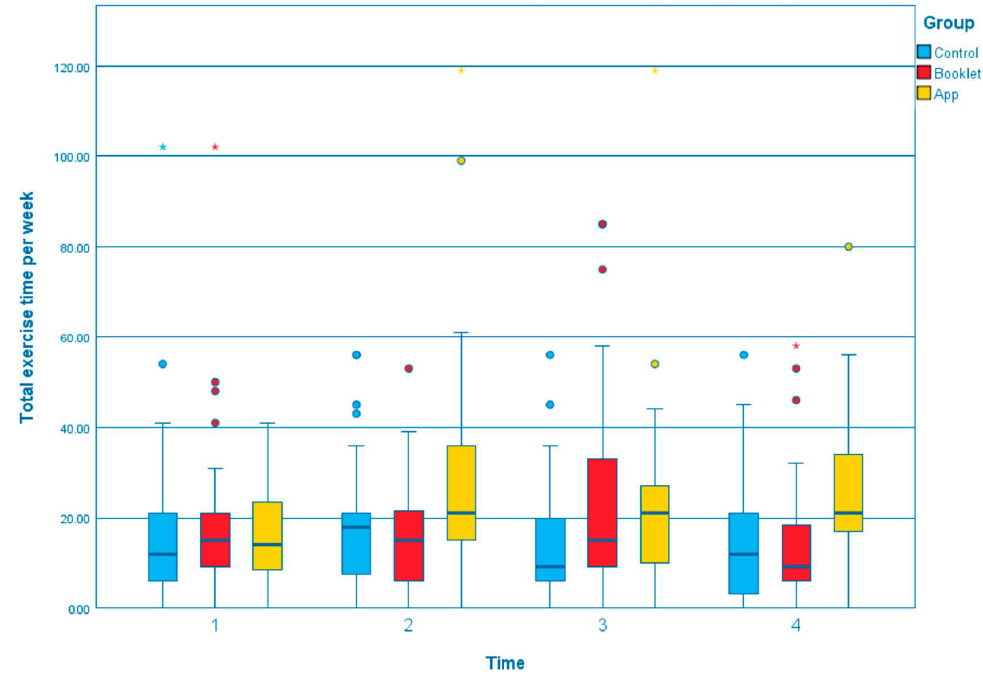
Figure 2. Boxplot of the change of total exercise time per week at different time point among the groups.